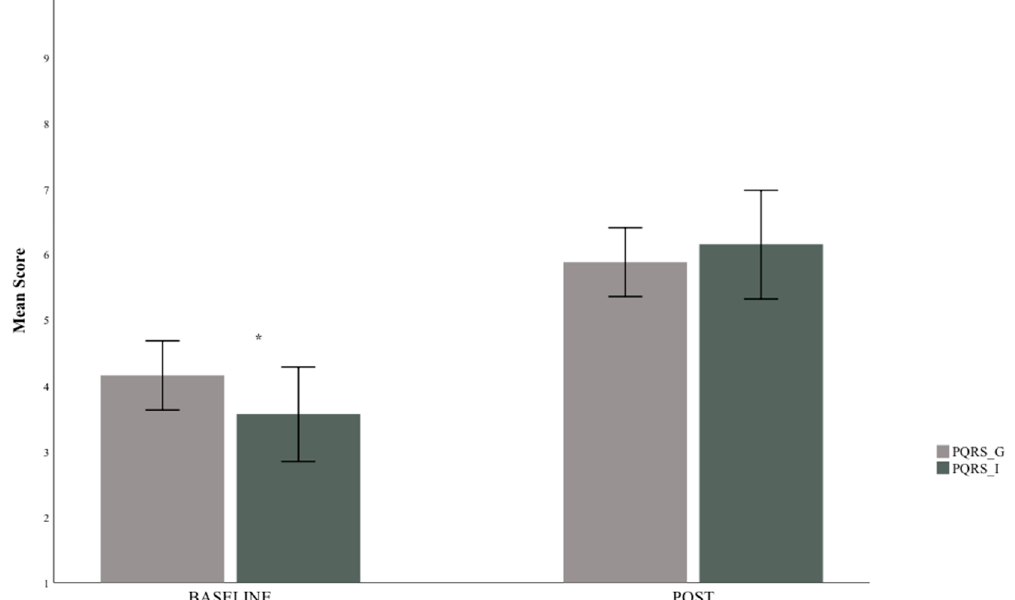
Figure 1. Comparing means at Baseline and at Post-Intervention. * indicates significant difference. PQRS-G = Performance Quality Rating Scale—Generic; PQRS- I: Performance Quality Rating Scale—Individualised.